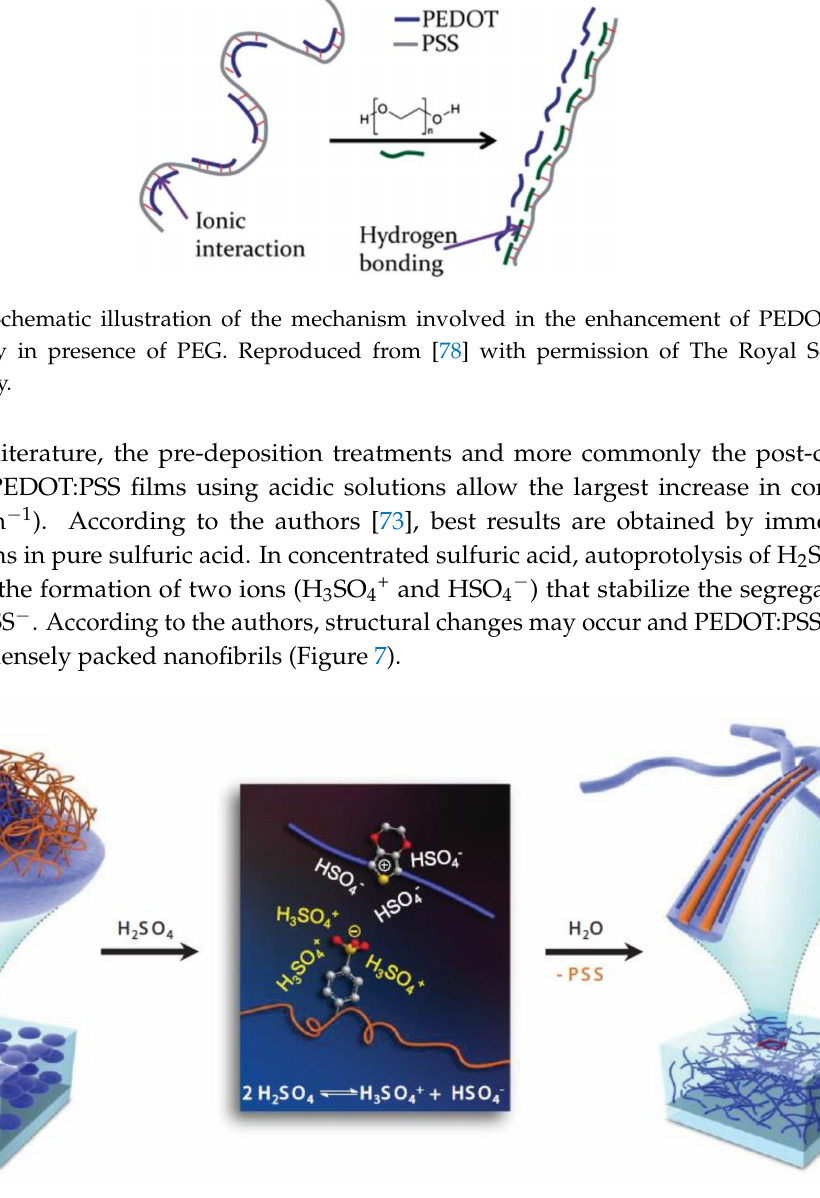
Figure 7. Diagram of the structural rearrangement of PEDOT:PSS. The amorphous PEDOT:PSS grains ( left ) are reformed into crystalline PEDOT:PSS nanofibrils ( right ) via a charge-separated transition mechanism ( middle ) via a concentrated H 2 SO 4 treatment. Reproduced from [73] with permission from John Wiley and Sons, Copyright ©